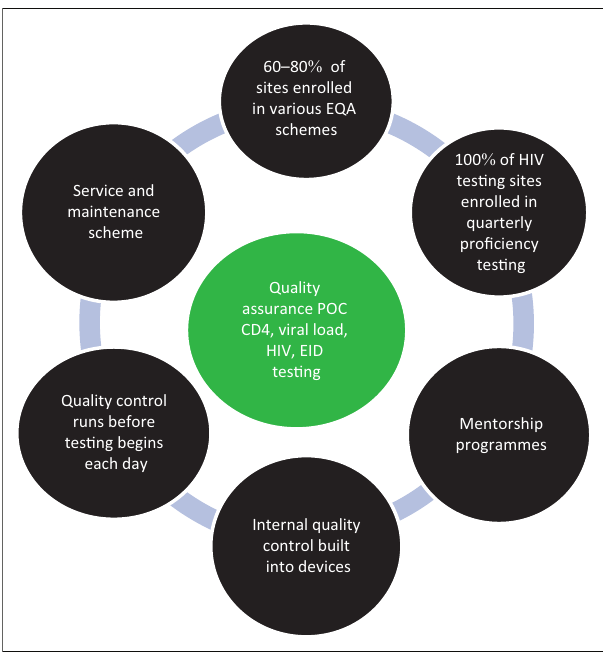
FIGURE 3: Schematic diagram of Malawi’s point-of-care testing testing quality assurance operational framework showing components that support the quality assurance